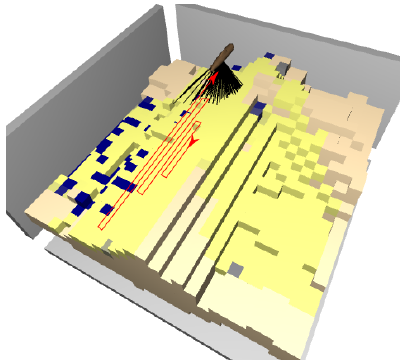
Figure 13. The agent starts to exhibit growing